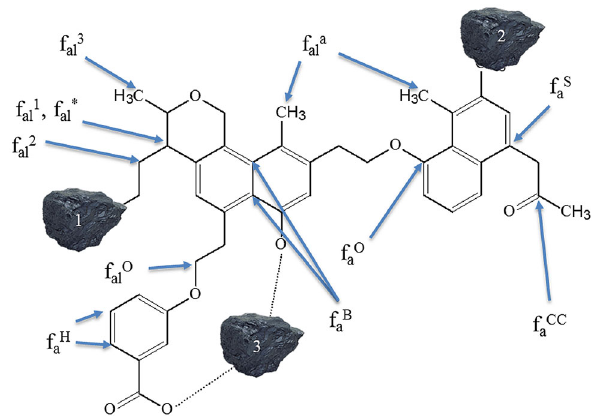
Fig. 1 Character of the carbon located